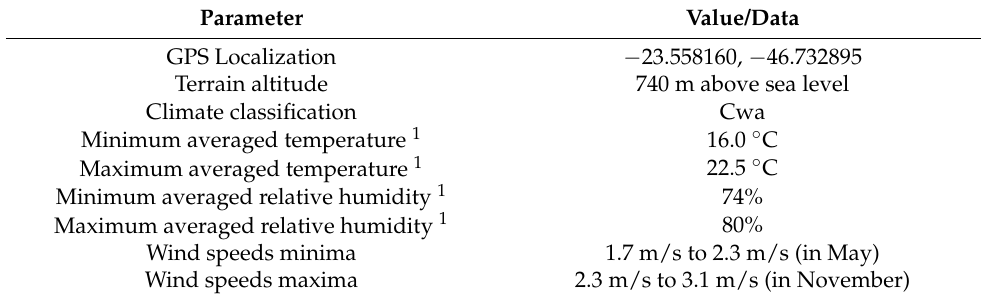
Table 1. Main climatology data summary.